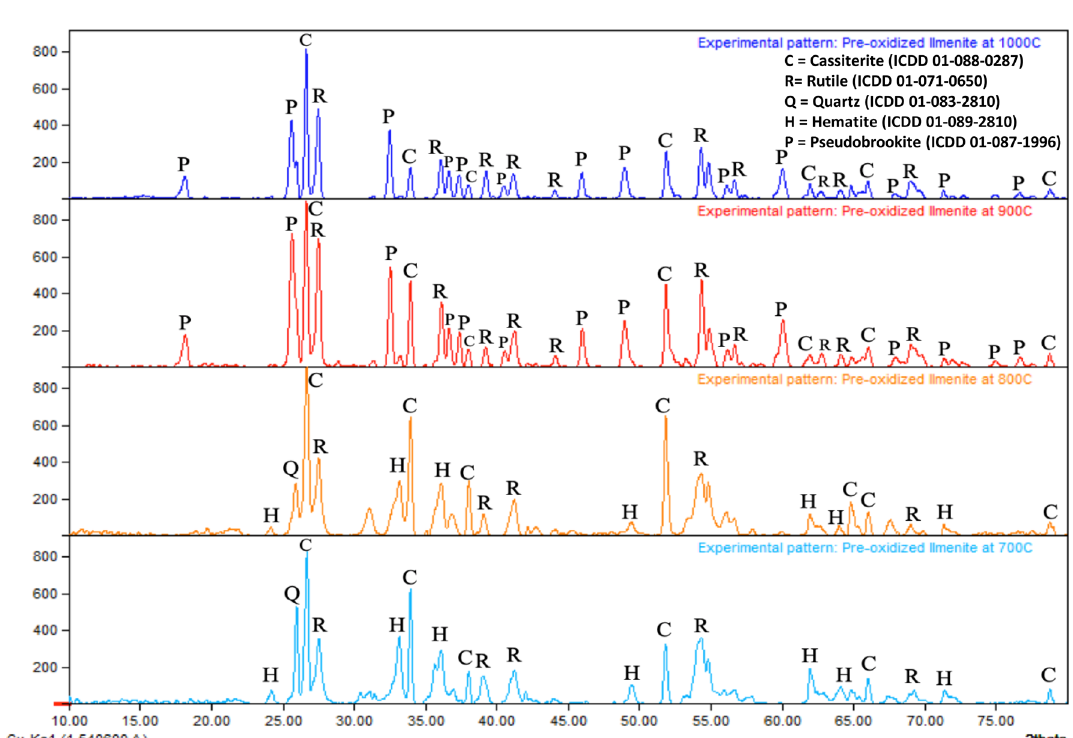
Figure 4. XRD patterns of the products of ilmenite pre-oxidation at various